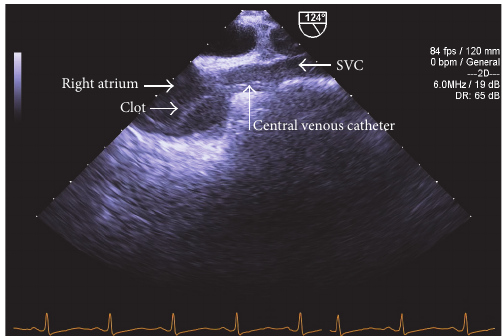
Figure 3: Preanhepatic phase. TEE midesophageal view: clot in the right atrium appears to be attached to 9 French catheter.